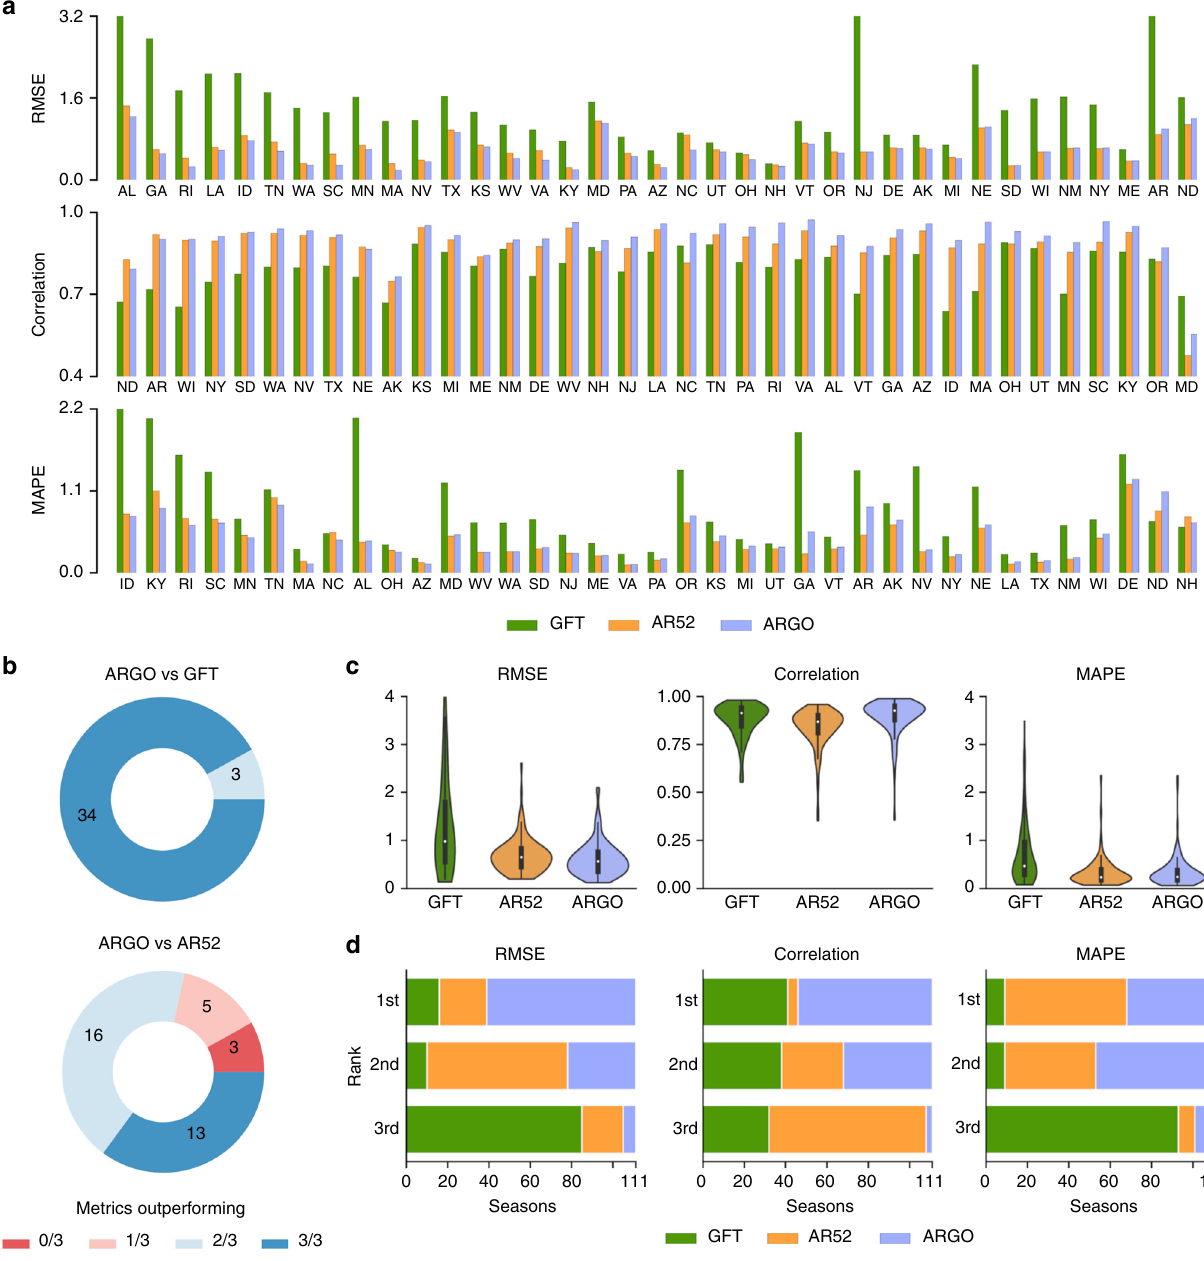
Fig. 1 Summary of ARGO performance benchmarked with GFT and AR52. a State-level performance of ARGO and benchmarks, as measured by RMSE (top), Pearson correlation (middle), and MAPE (bottom), over the period from September 30, 2012 to August 15, 2015. Extreme GFT error values are displayed up to a cutoff point. States are ordered by ARGO performance relative to the benchmarks to facilitate comparison. b The proportion of states where ARGO outperforms GFT (top) or AR52 (bottom) in 0, 1, 2, or all 3 metrics. c The distribution of values for each metric for each model, over the 111 state-seasons during the same period. The embedded boxplots indicate median and interquartile ranges. Numerical values are reported in Supplementary Table 1. d The distribution of ranks attained by each model over the 111 state-seasons for each